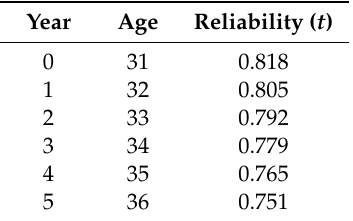
Figure 9. Reliability, survival, behavior for the cohort (CI < 150 mm). Table 7. Reliability computations for a pipe segment in LWDN.